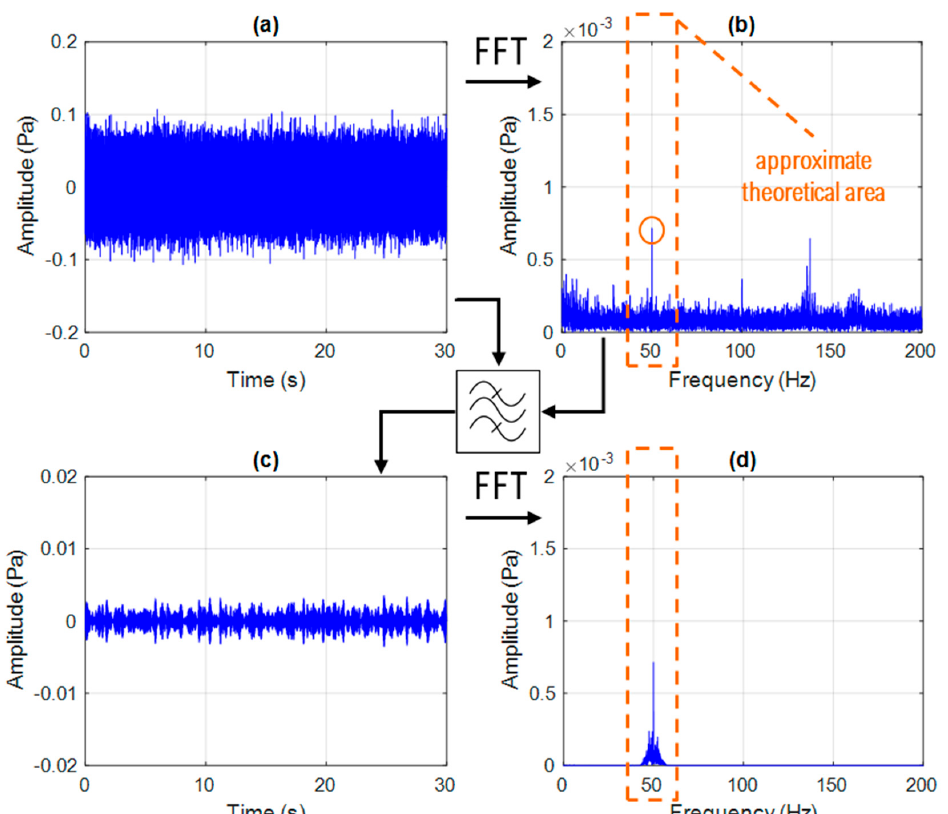
Figure 3. Diagram representing the isolation of belt vibration frequency from the recorded signal: ( a ) signal recorded from the measuring head above the belt, ( b ) signal spectrum above the belt, ( c ) filtered frequencies located within a close range to the frequencies of belt transverse vibrations, and ( d ) spectrum of the filtered signal.